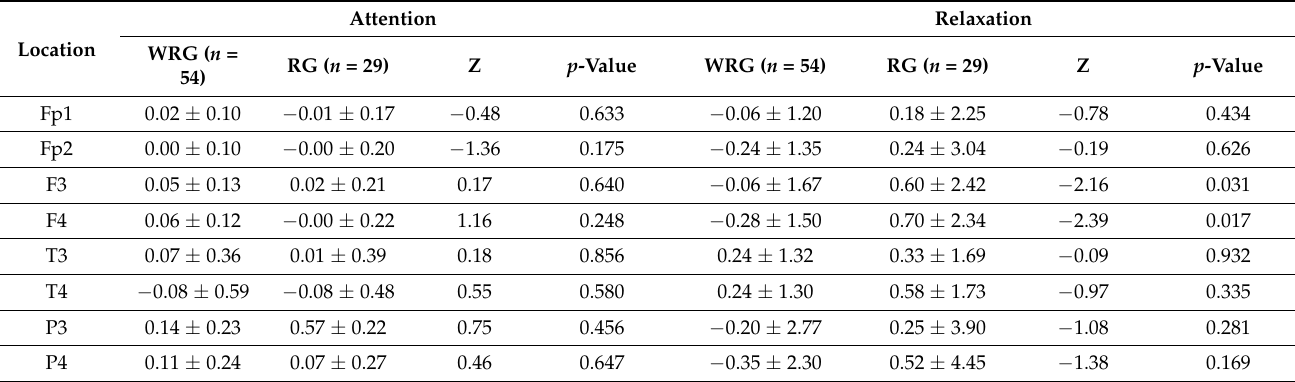
Table 3. The differences between before and after digital learning in the level of attention and relaxation between the risk and without-risk